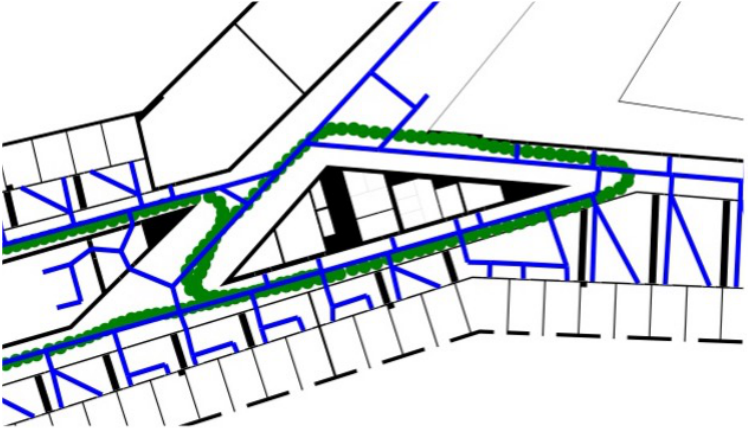
Figure 15. Trajectory (green dots) from the cl method for the eight path without step length correction for the backtracking